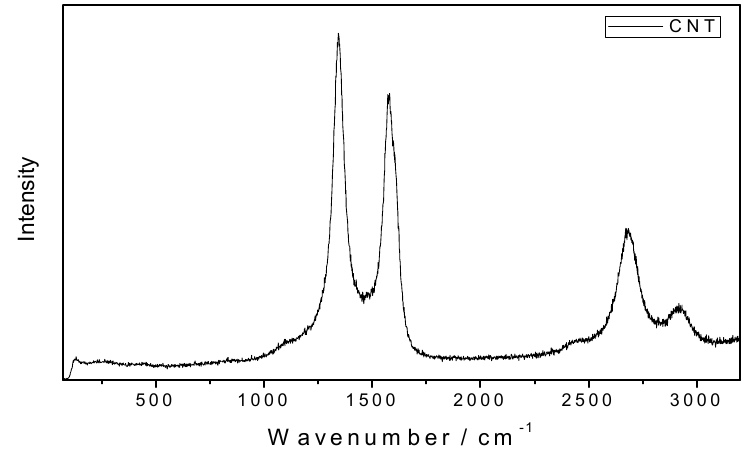
Figure 6. Raman spectra of the multi-wall carbon nanotubes (MWCNT) bulk material.